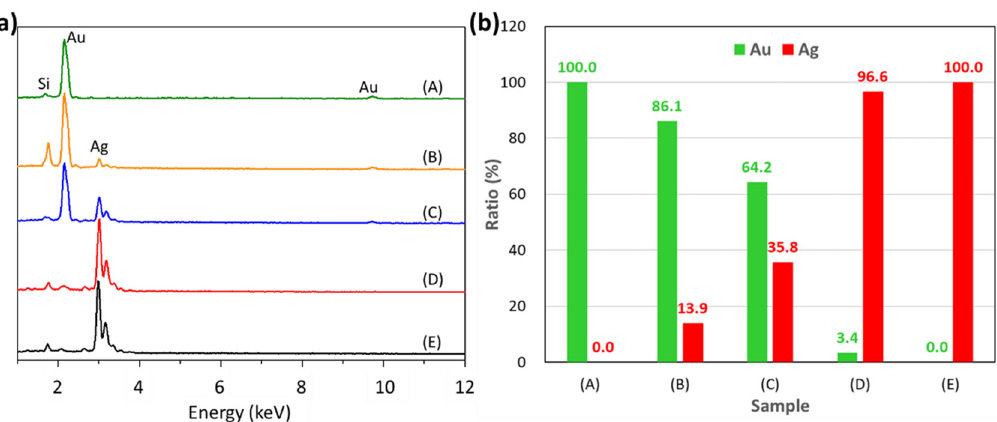
Figure 5. ( a ) EDX data of the various synthesized Au@Ag-DNFs/Si samples. ( b ) Green and red columns denote the respective signals of the Au and Ag of the EDX peak.